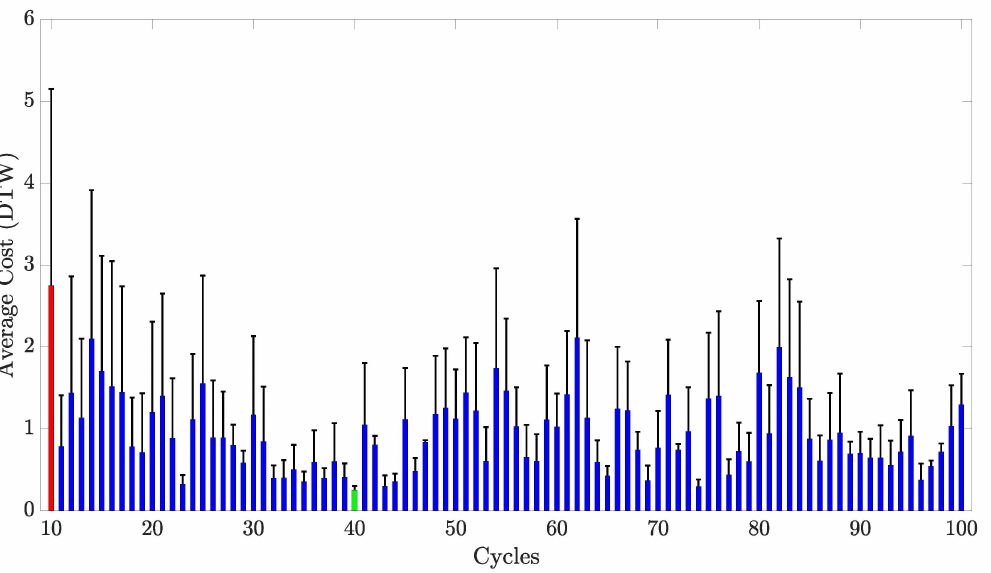
Figure 16. Average DTW cost across the three sensor samples for Cycles 10 to 100. The cost function was computed using the squared euclidean distance for each sensor pair combination. The highest average cost function (2.752 ± 2.398) was for the 10th cycle (in red), whereas the lowest average cost function (0.25 ± 0.052) corresponded to the 40th cycle and is shown in